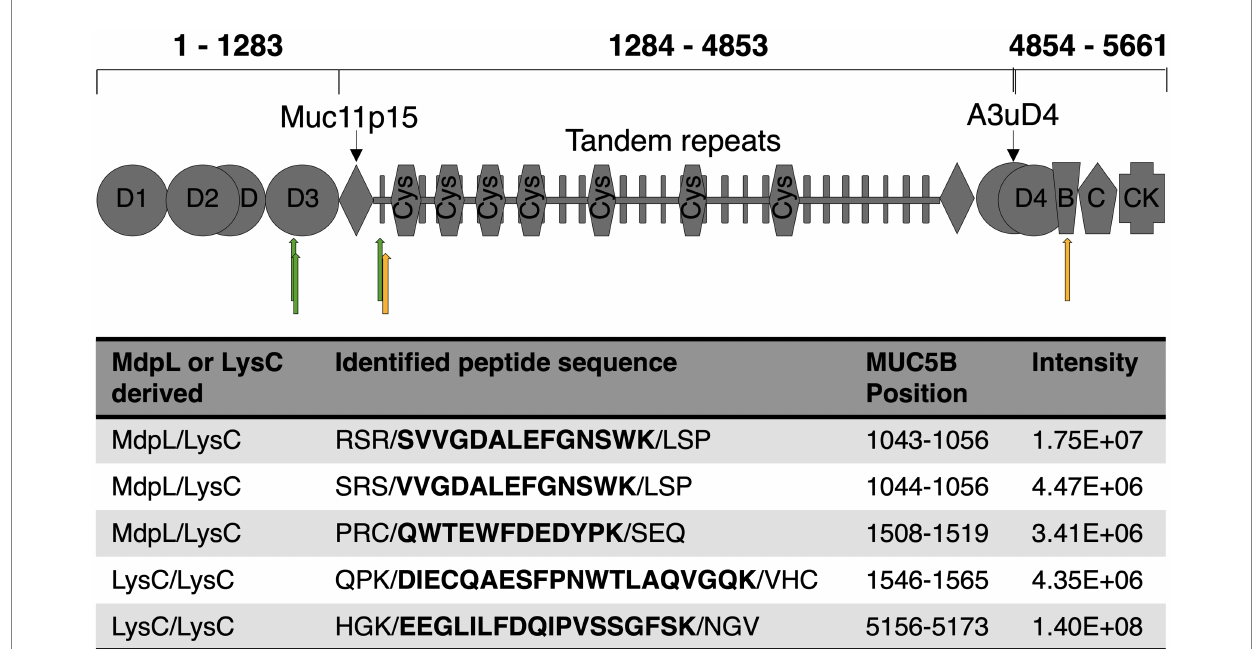
FIGURE 5 Overview of MdpL hydrolysis on MUC5B. Green and yellow arrows mark the hydrolysis of MdpL/Lys-C, and Lys-C/Lys-C, respectively, subjected to LC–MS/MS, as shown on a schematic figure of main MUC5B domains adapted from Zaretsky and Wreschner (2013a). D1-4: Dimerization domains, von Willebrand factor-like (vWF) containing N-glycosylation sites; Muc11p15: A cysteine and proline-rich peptide conserved in other gel-forming mucins; Tandem repeats: Domain rich in PST-repeat, generally containing a vast amount of O-glycosylation sites; Cys: Cysteine-rich (~10%) subdomain; A3uD4: Domain located between A3 and D4 in vWF; B: vWF type B domain; C: vWF type C domain; CK: Cysteine knot, strictly conserved in all gel- forming mucins. The table depicts the identified peptide sequences resultant to the enzymatic hydrolysis seen after 24 h incubation.